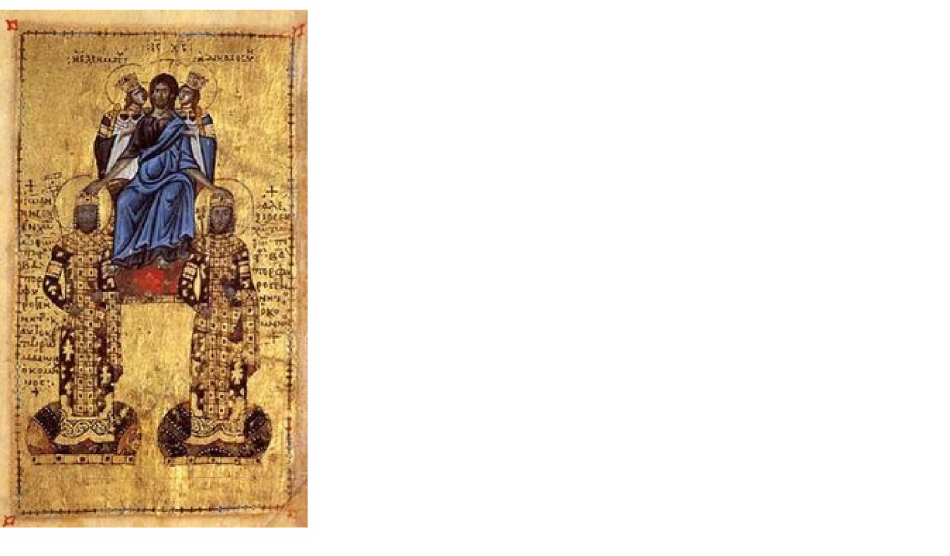
Figure 2. Coronation of John and Alexios by Christ; illumination; post 1119; Vatican Library, Tetrae- vangelion, Vat.Urb.gr.2, Dedication Image. Published in [2] (p. 147), [3–5] (p.